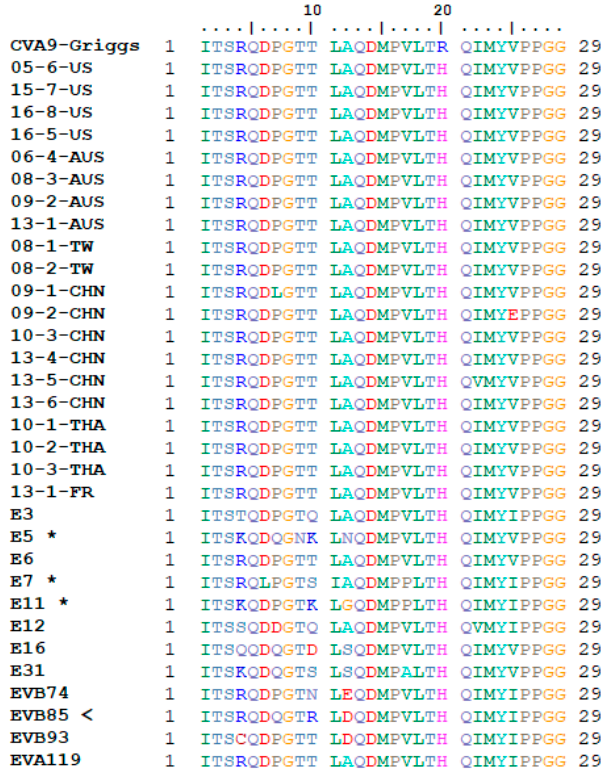
Figure 3. CVA9 HS binding domain. VP1 position 132 in the prototype strain Griggs is equivalent to position 10 in the alignment, where the T132R/K mutation has been identified for enabling HS binding. Three types with previously detected HS binding sites are marked with an asterisk, while the EVB85 marked with an arrow is new. None of the full length CVA9 sequences from GenBank exhibited the T132R/K